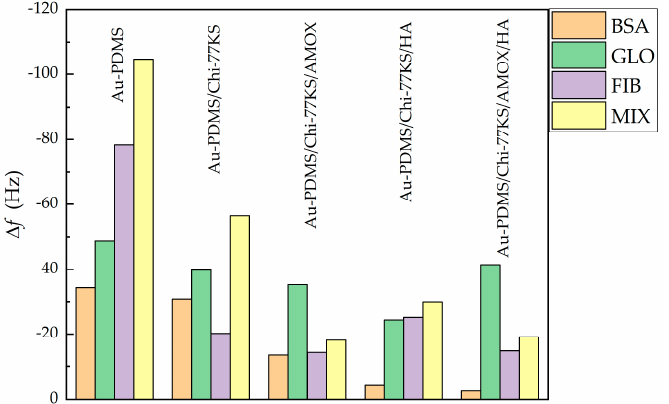
Figure 10. Δ f of BSA, FIB, γ G and Mix after the rinsing step for Au-PDMS, Au-PDMS/Chi-77KS, Au- PDMS/AMOX [35], Au-PDMS/Chi-77KS/HA and Au-PDMS/Chi-77KS/AMOX/HA. Table 4. Viscoelastic properties—the adsorbed mass ( Γ QCM ), film thickness ( h f ), viscosity ( η f ), and elastic shear modulus ( μ f ) of adsorbed mixed protein (Mix) layer onto various samples, including first (Chi-77KS, Chi-77KS/AMOX) and the second layer